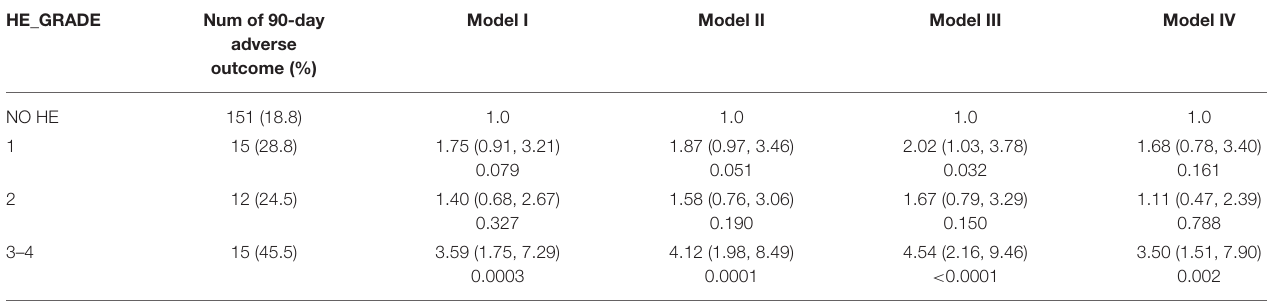
Model I, unadjusted. Model II, adjusted for age, sex, etiology.